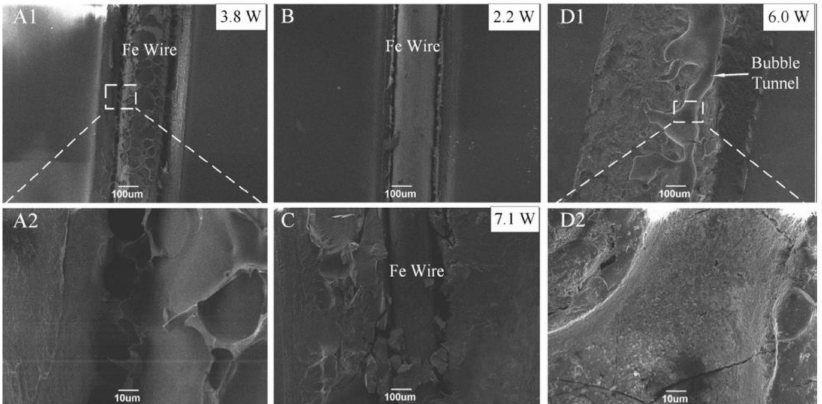
Figure 18. SEM images of welding seams at various sections of Fe wire ( A – C ) and CB( D ) group after undergoing tensile testing with V = 1 mm/s and C = 0.4 MPa [208] Reproduced with permission from Ref. [208]. Copyright (2018), Optics and Laser